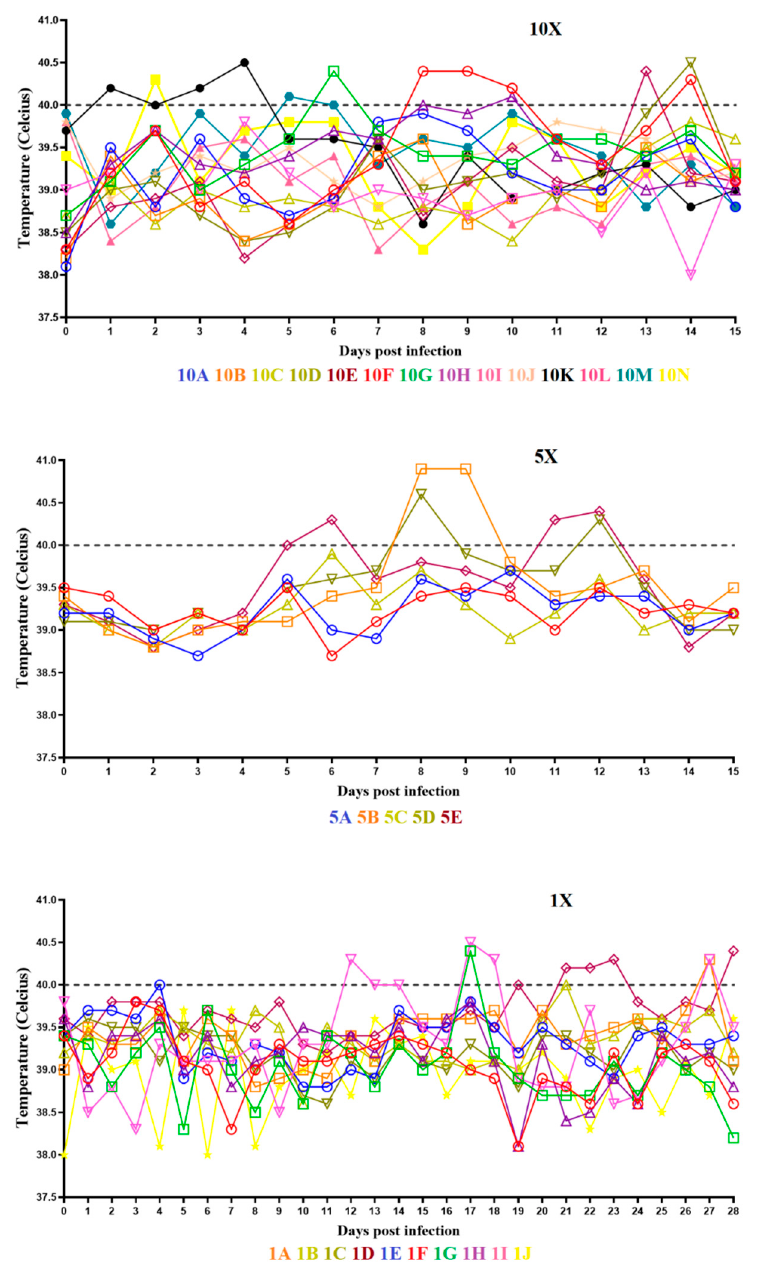
Figure 1. Evolution of body temperature in animals IM inoculated with either 10 3.6 HAD 50 (panel 10X), 10 3.3 HAD 50 (panel 5X), or 10 2.6 HAD 50 (panel 1X) of ASFV-G- ∆ I177L. Data are presented as individual values (expressed as °C) for each of the inoculated animals in each of the different groups.